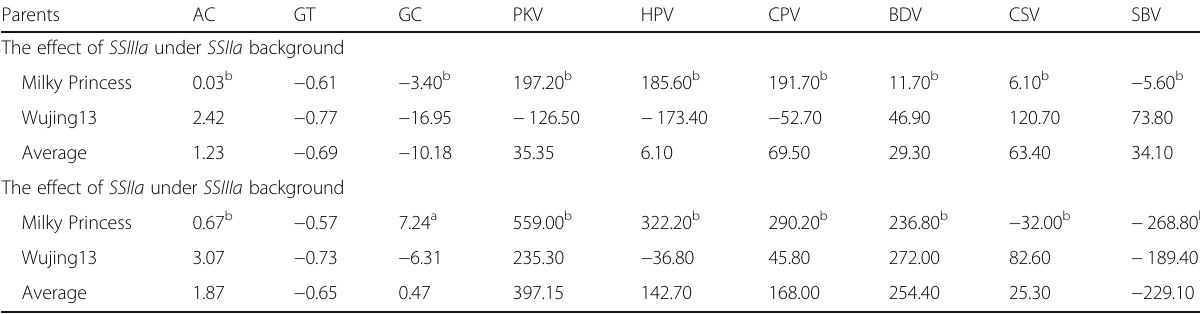
Table 8 Genetic effect of SSIIa and SSIIIa in different background of parent Parents AC GT GC PKV HPV